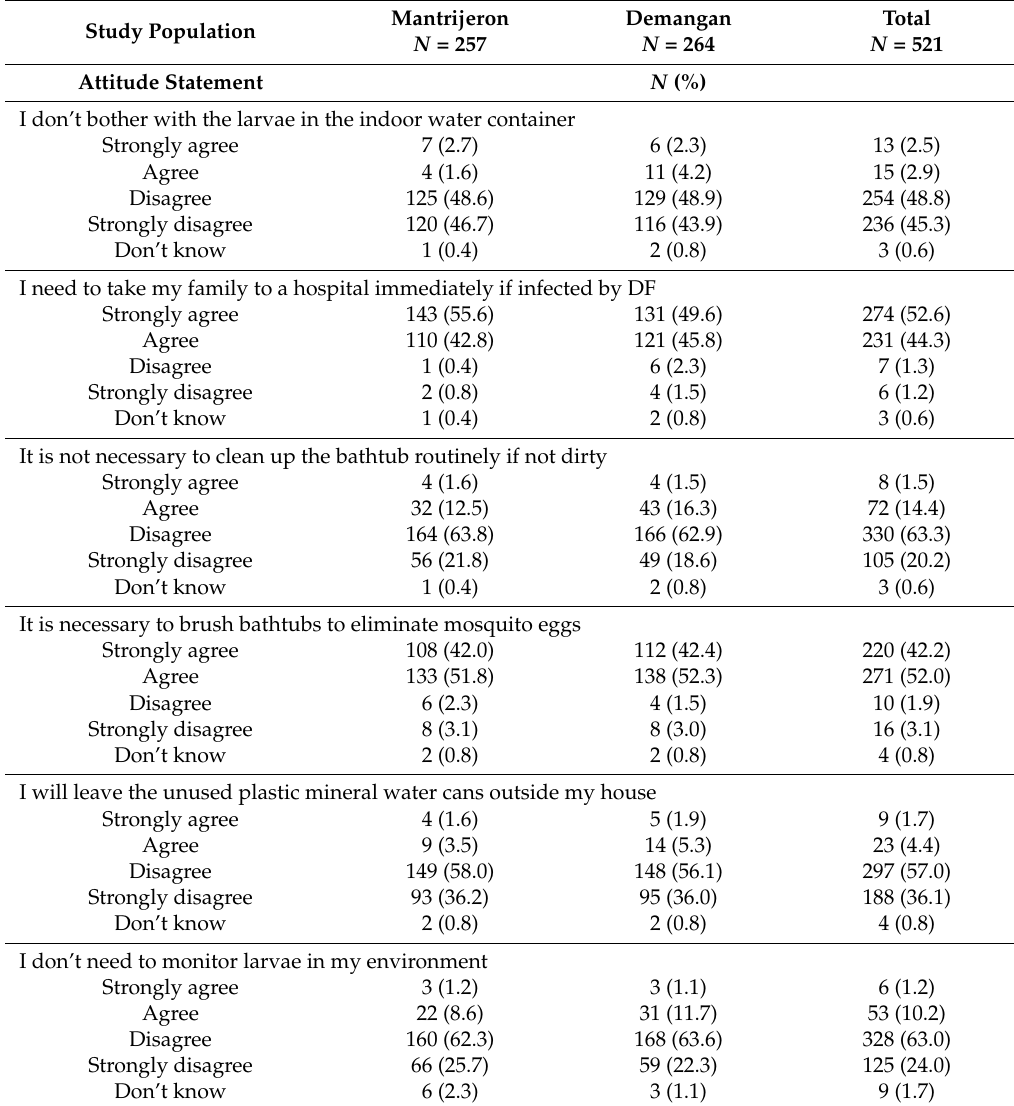
Table 3. Attitude towards Dengue Fever (DF) prevention and treatment. Study Population